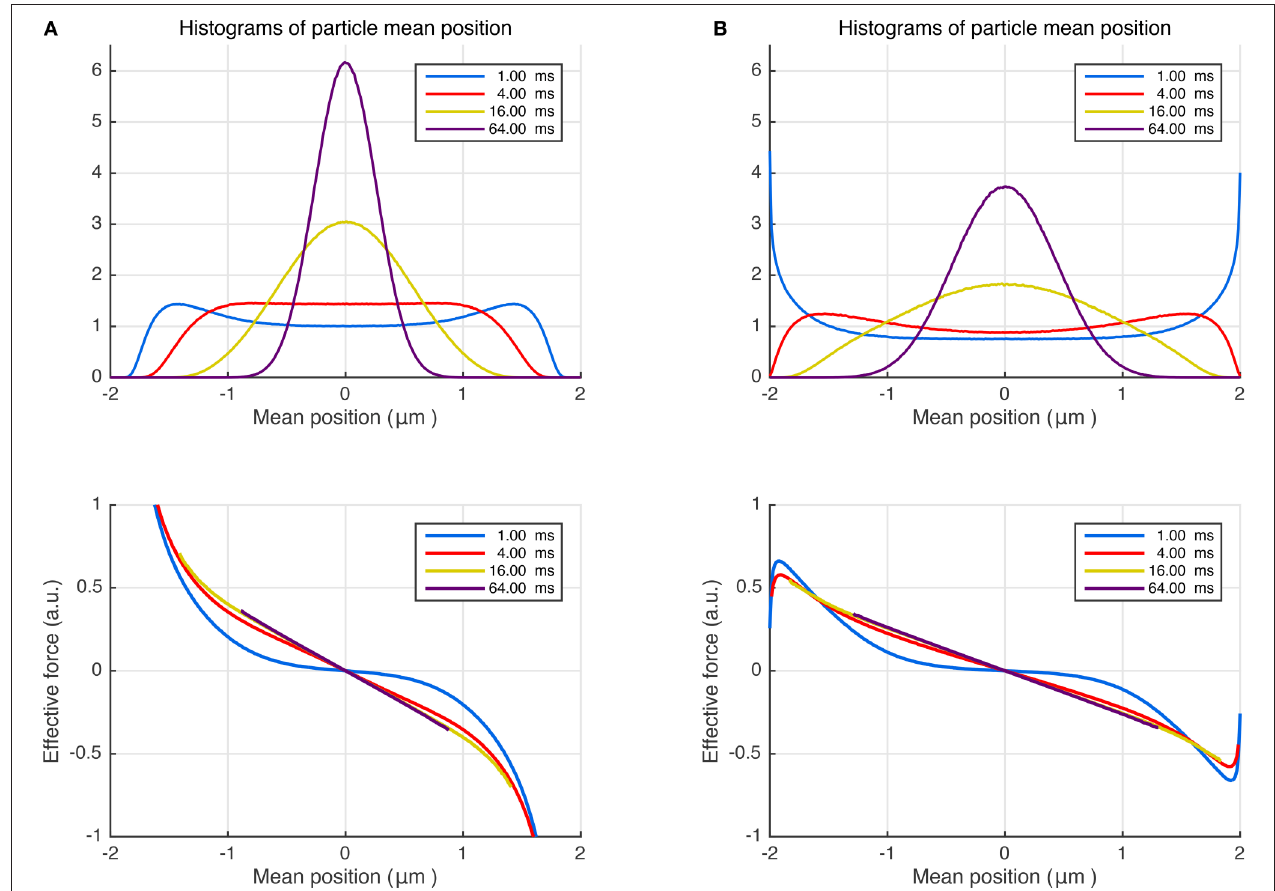
FIGURE 2 | (A) Random walk simulations for particles trapped between non-sticky parallel plates separated by 4 µ m, diffusing with bulk diffusivity D Different curves represent different time intervals, which can be associated with durations of the pulses in NMR measurements. The distributions of the positions of the center of mass are shown at the top. The average effective force exerted on the diffusing particles plotted vs. the trajectories’ center of mass (bottom). (B) The simulations were repeated by introducing surface adsorption effect so that the particles spend, on average, 25% of the time stuck at the